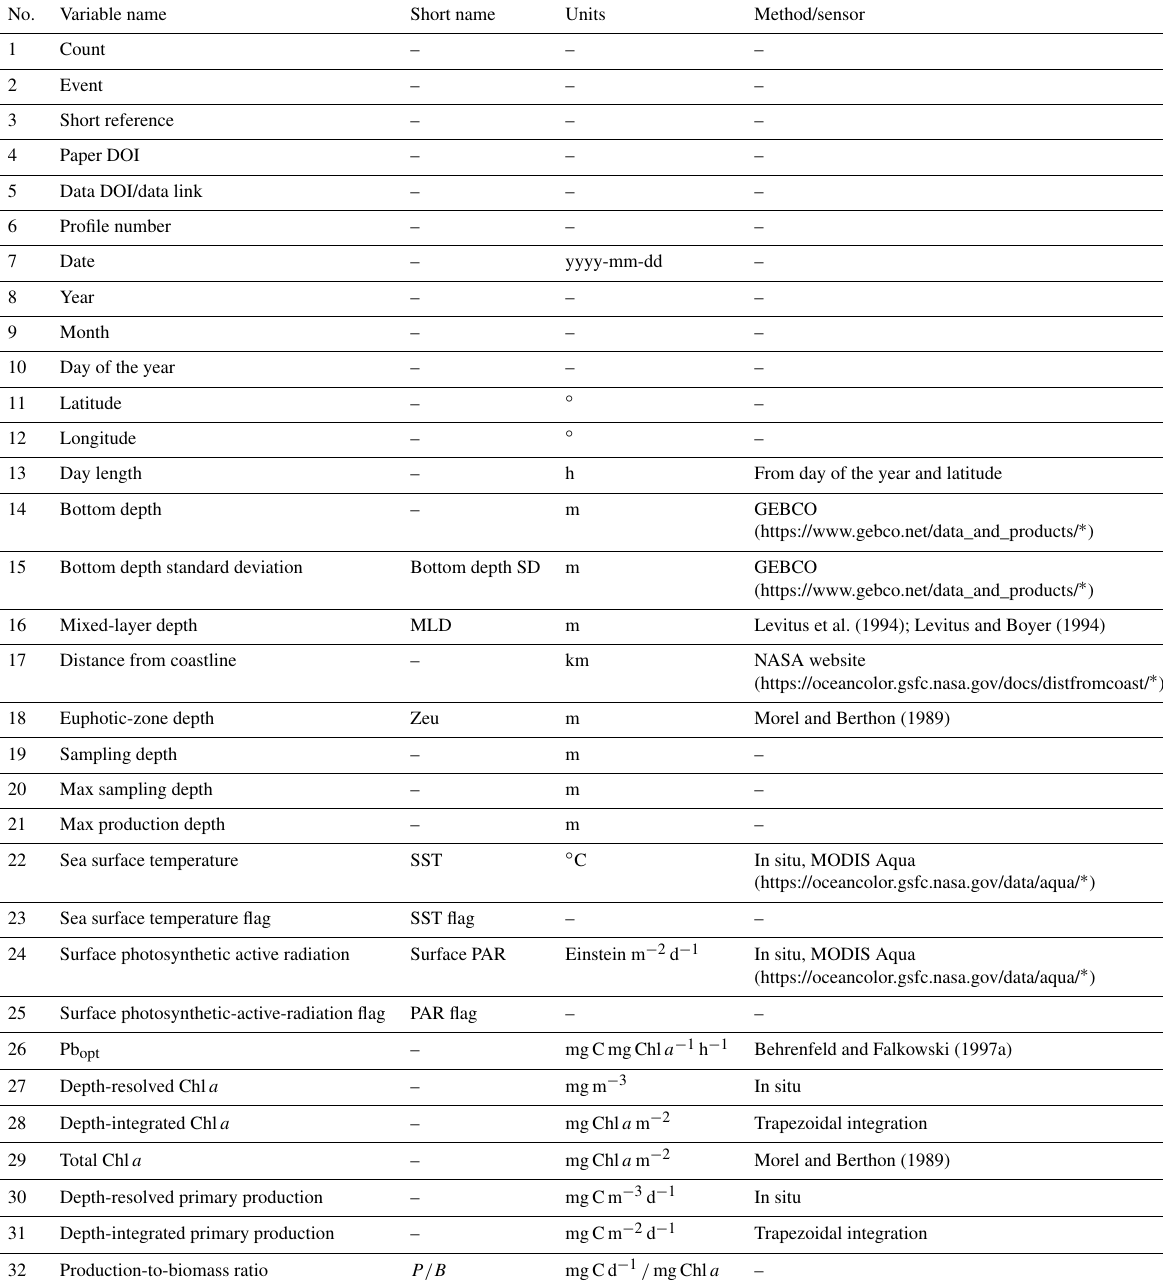
Table 1. Production dataset numerical